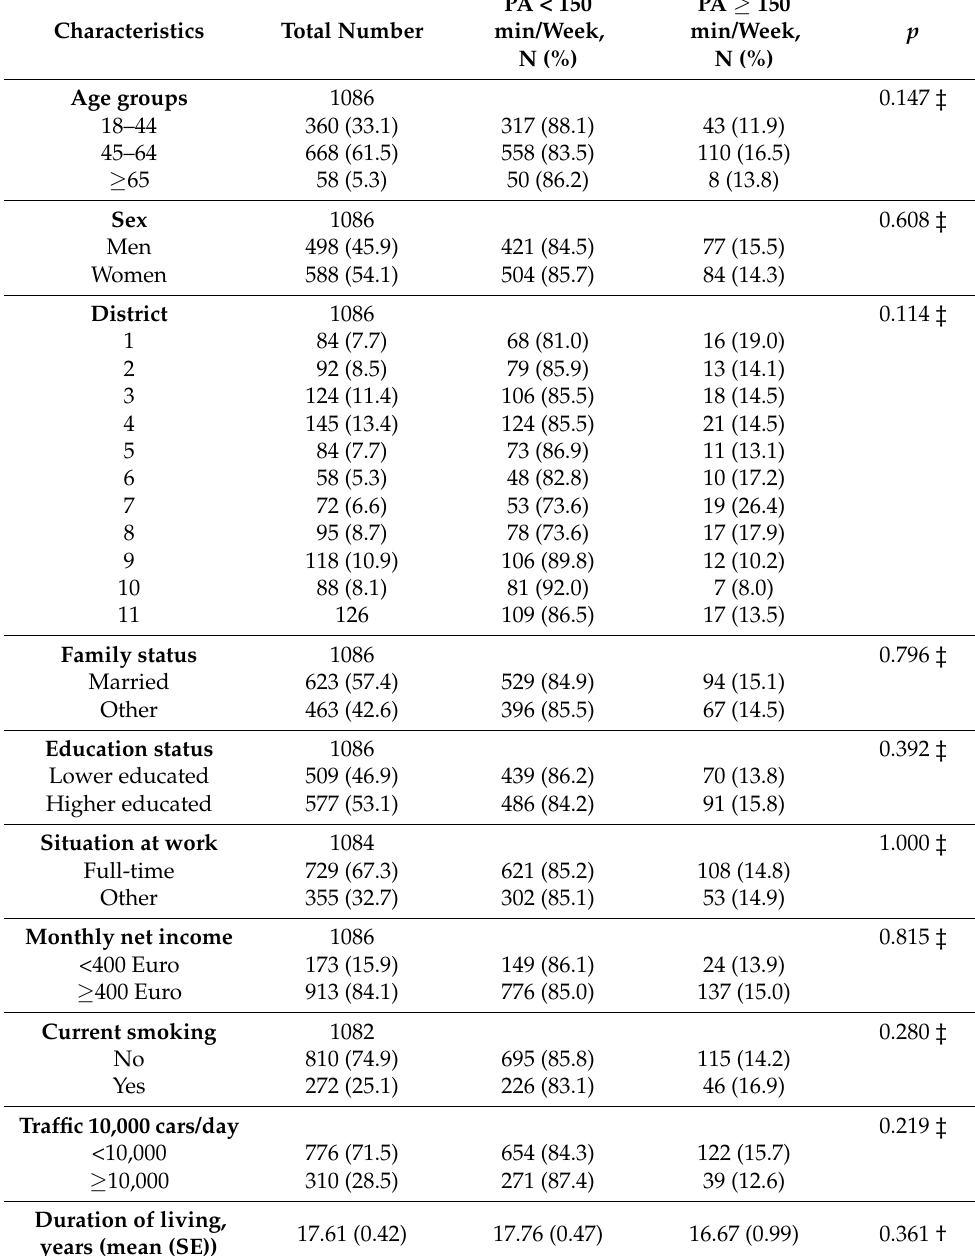
Table 1. Characteristics of the 18–75-year-old participants by physical activity